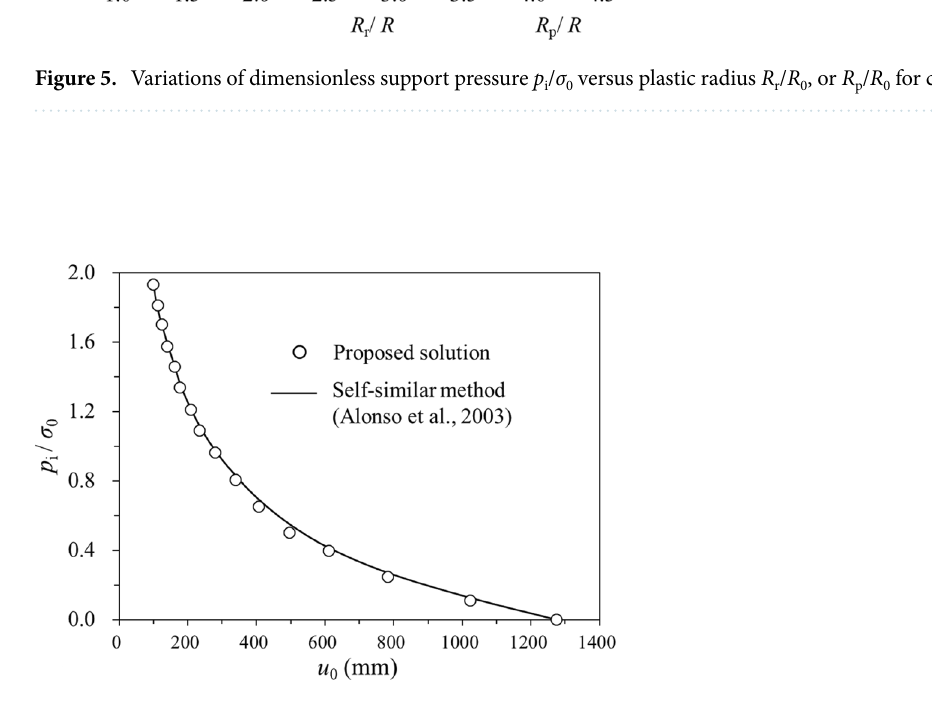
Figure 6. Ground reaction curve for case